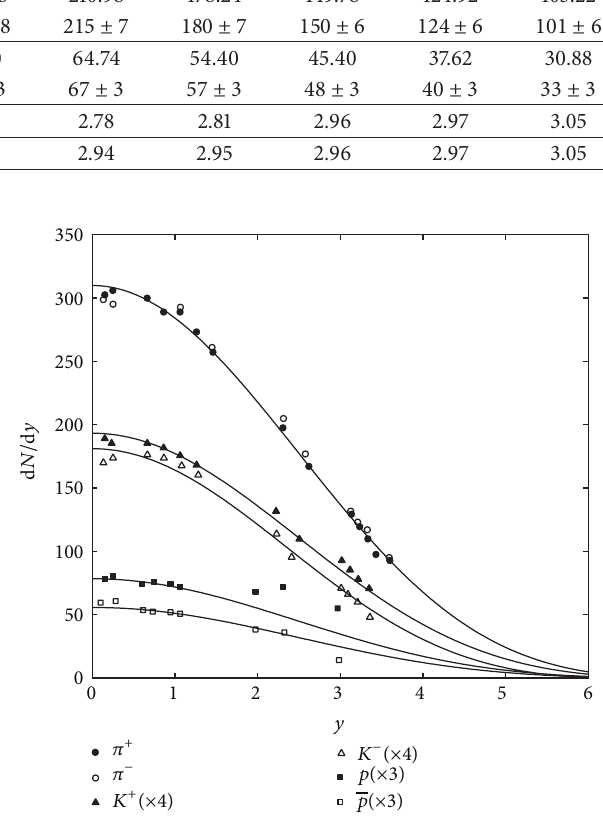
Figure 1: The rapidity distributions of specified charged particles in = 200 GeV. The scattered symbols central Au-Au collisions at √𝑠 NN are the experimental measurements [24–26]. The solid curves are the results from the evolution-dominated hydrodynamics of